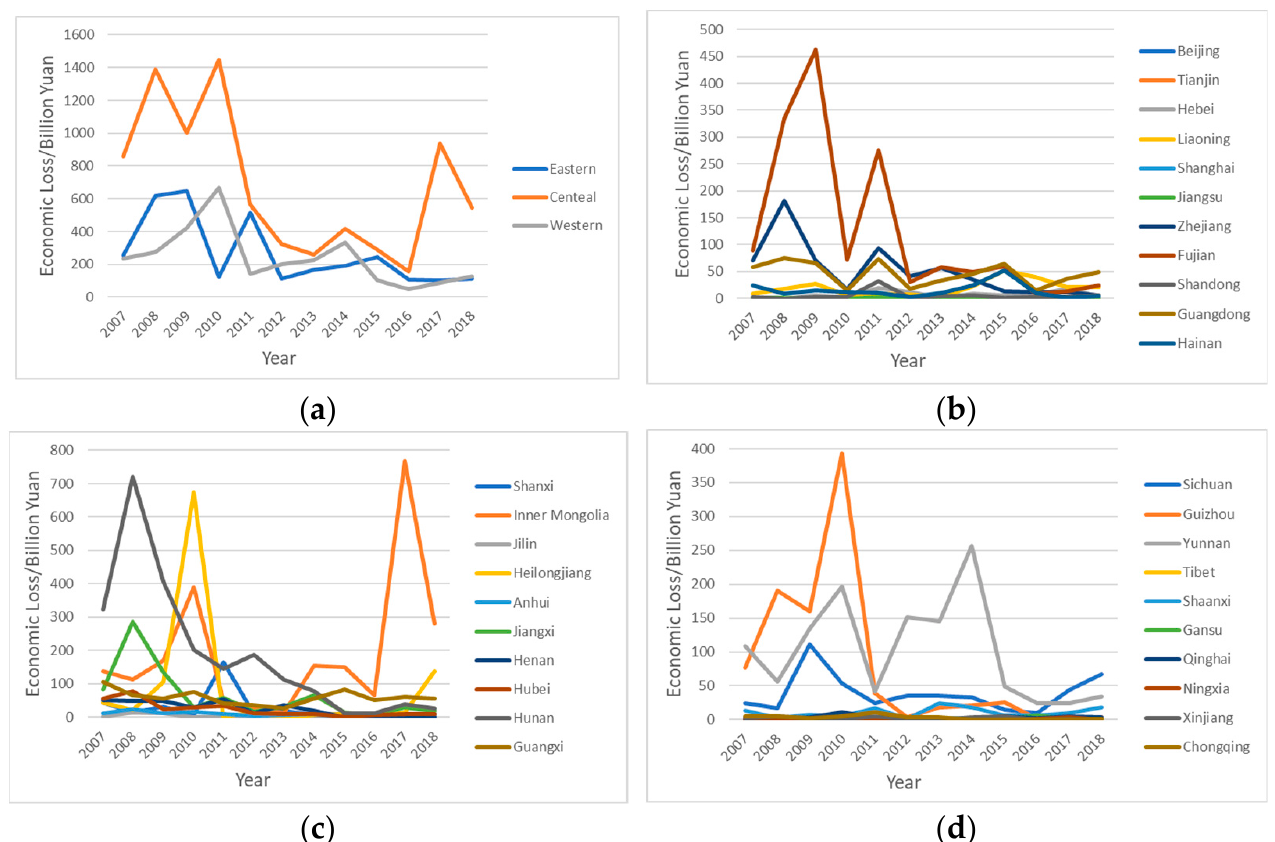
Figure 2. Trend of economic losses caused by forest fires in China. ( a ) Overall changes in economic losses caused by forest fires in three regions of China. ( b ) Changes in economic loss caused by forest fires in eastern provinces of China. ( c ) Changes in central loss caused by forest fires in eastern provinces of China. ( d ) Changes in economic loss caused by forest fires in western provinces of China.